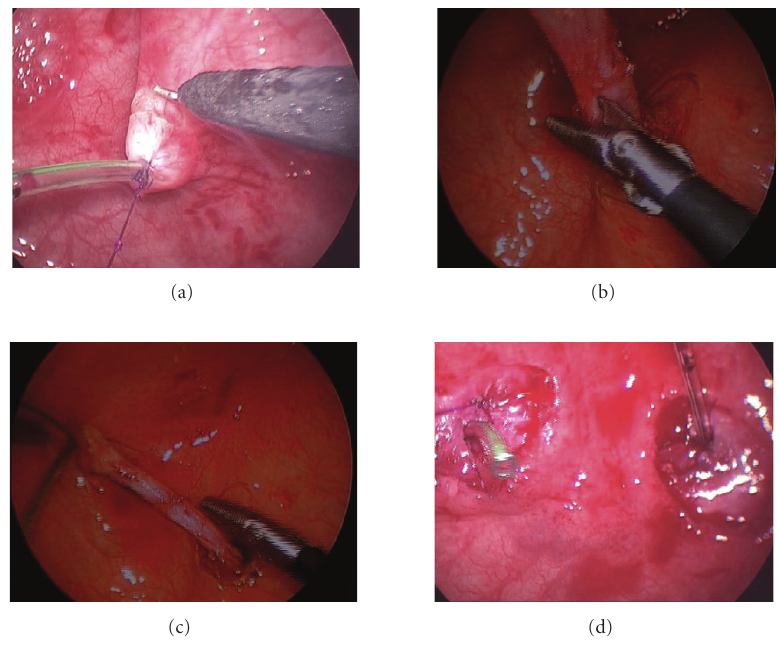
Figure 4: (a) Initial dissection with hook electrode at low-power setting. (b) Investing detrusor bands divided using sharp dissection. (c) Ureter has been mobilized such that it can reach the contralateral side with no tension. (d) View after bilateral mobilization and closure of the posterior detrusor openings. Ureters have been pushed back out of bladder to permit visualization of the bladder mucosa-detrusor plane to permit creation of the submucosal tunnels.